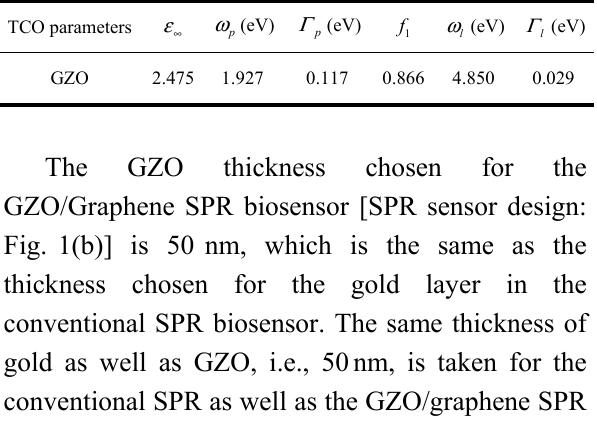
Table 1 Drude-Lorentz oscillator’s parameter for